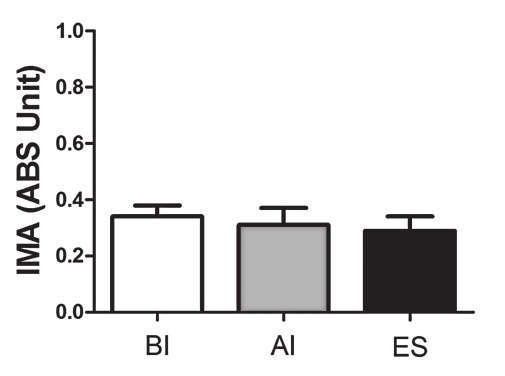
Figure 3 - serum IMa levels at three time points (bI: before induction, aI: after induction, Es: End